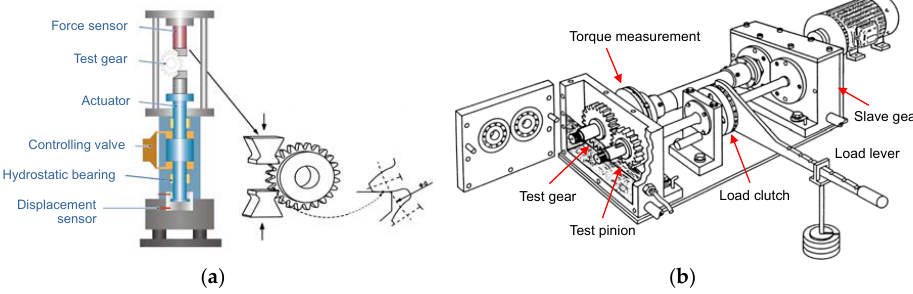
Figure 13. Equipment for gear testing used at FZG: ( a ) pulsator test rig for investigations of the tooth root load carrying capacity; ( b ) back ‐ to ‐ back gear test rig for investigations of the flank load carrying capacity.